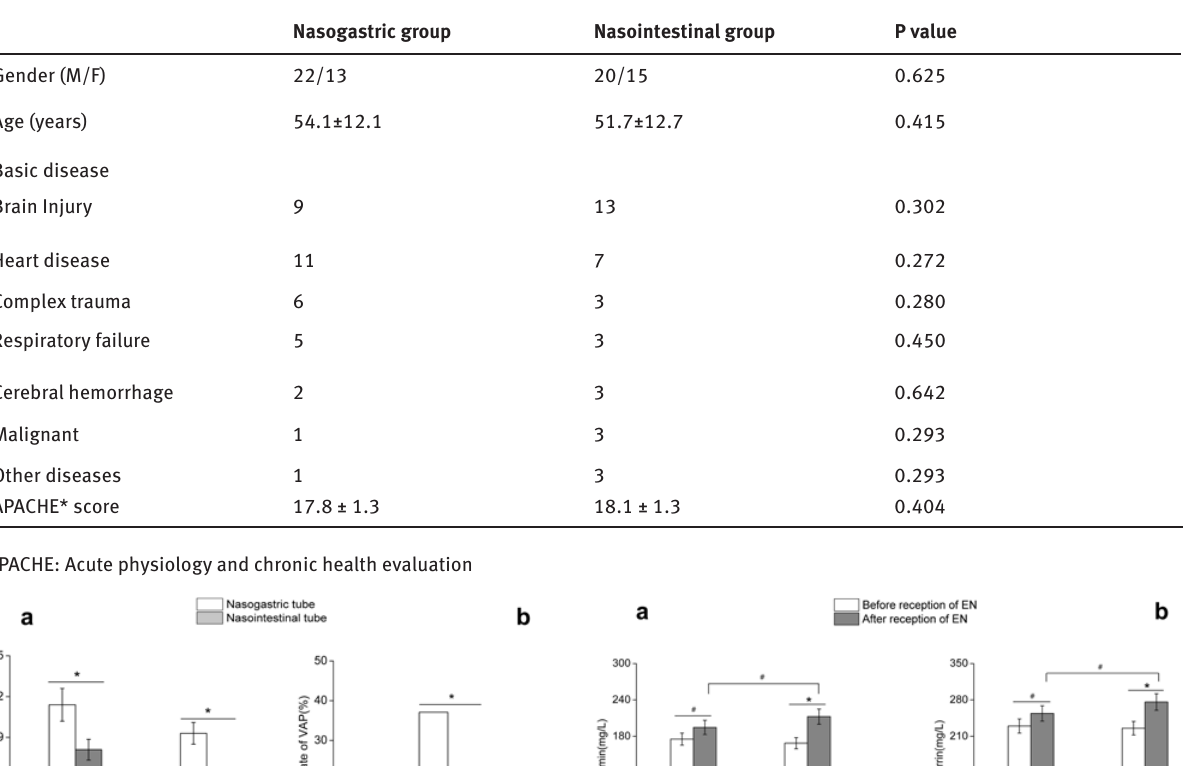
Table 1: Baseline characteristics of patients